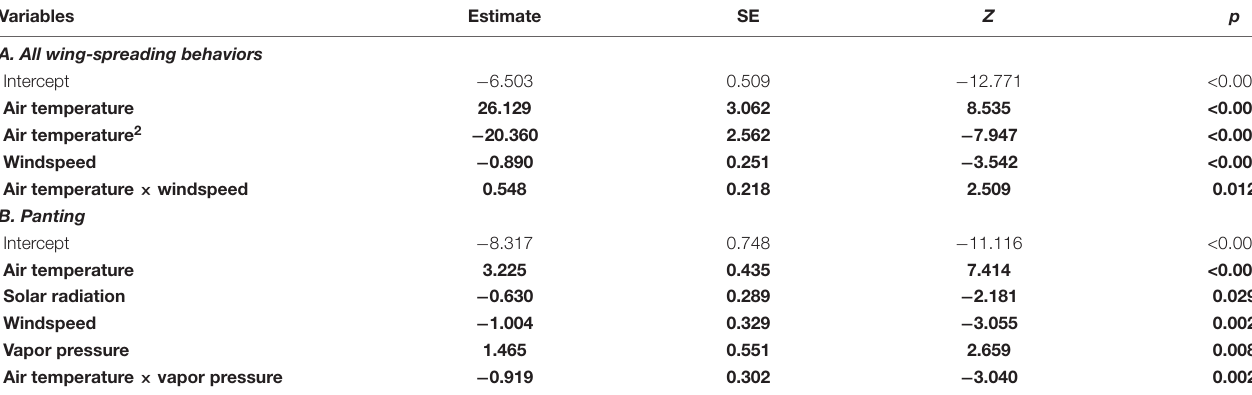
TABLE 3 | Results of zero-inflated models with beta-binomial distribution (glmmTMB) testing for factors associated with the proportion of time spent undertaking heat dissipation